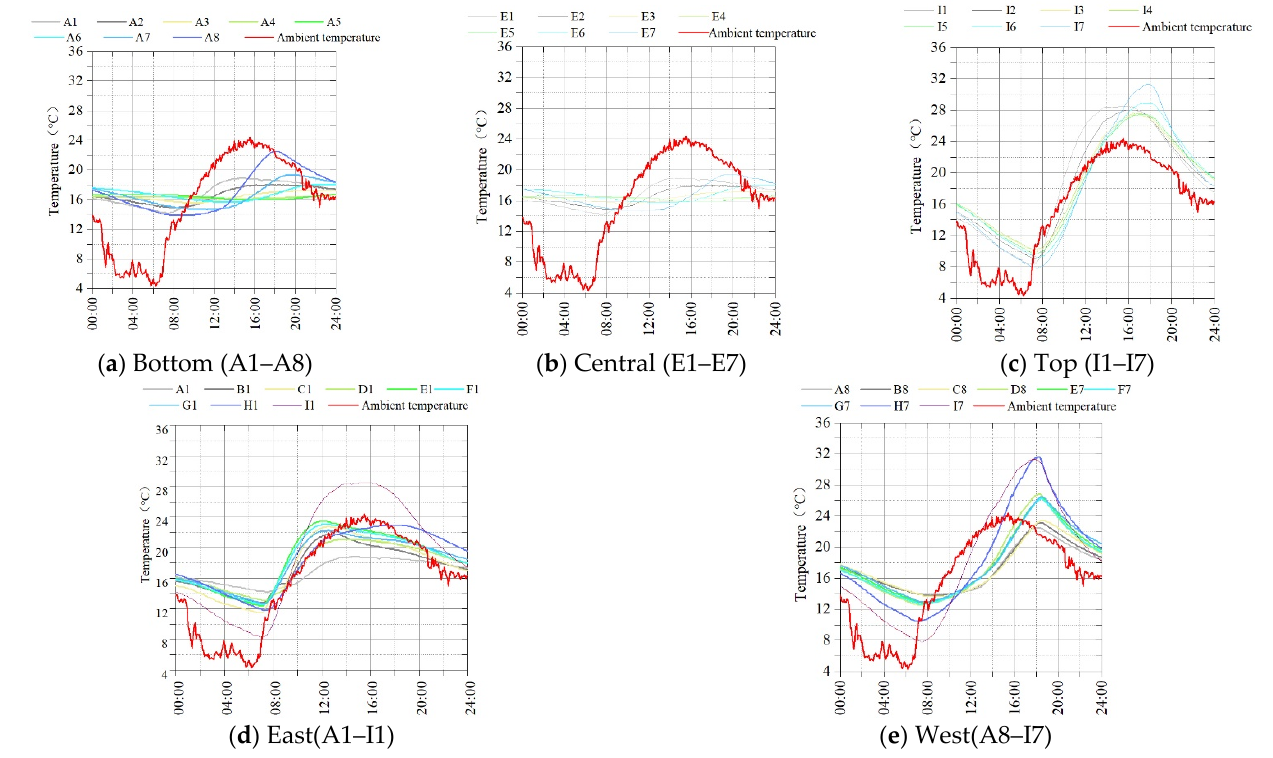
Figure 23. Diurnal wall temperature change with maximum atmospheric temperature difference in spring (22 April 2017).